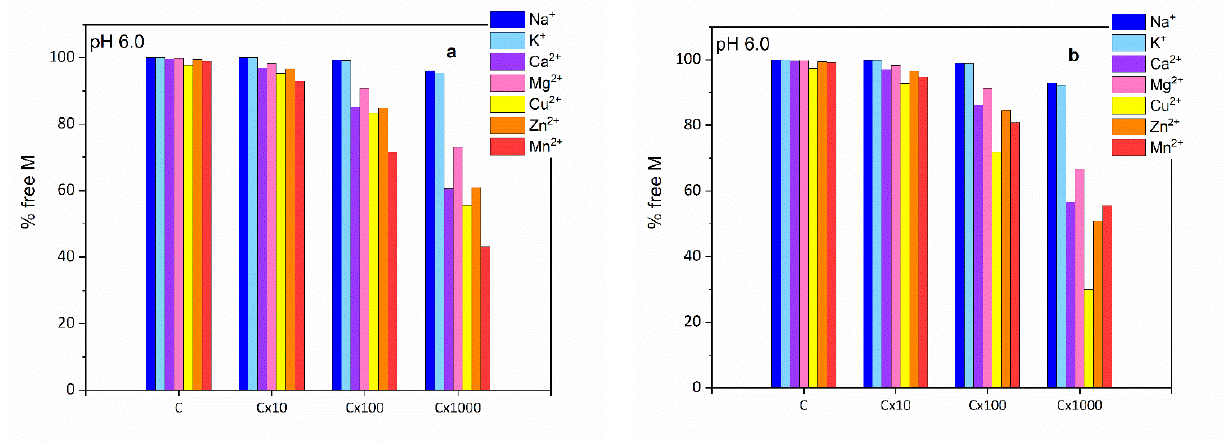
Figure 6. Percentages of free cations in solution, as a function of the concentration level of the components, at pH 6.0. Here, the concentrations of the atmospheric deposition sample D1-1 ( a ) and D3-2 ( b ) are those determined in deposition samples (C) or multiplied by a factor 10, 100, or 1000.